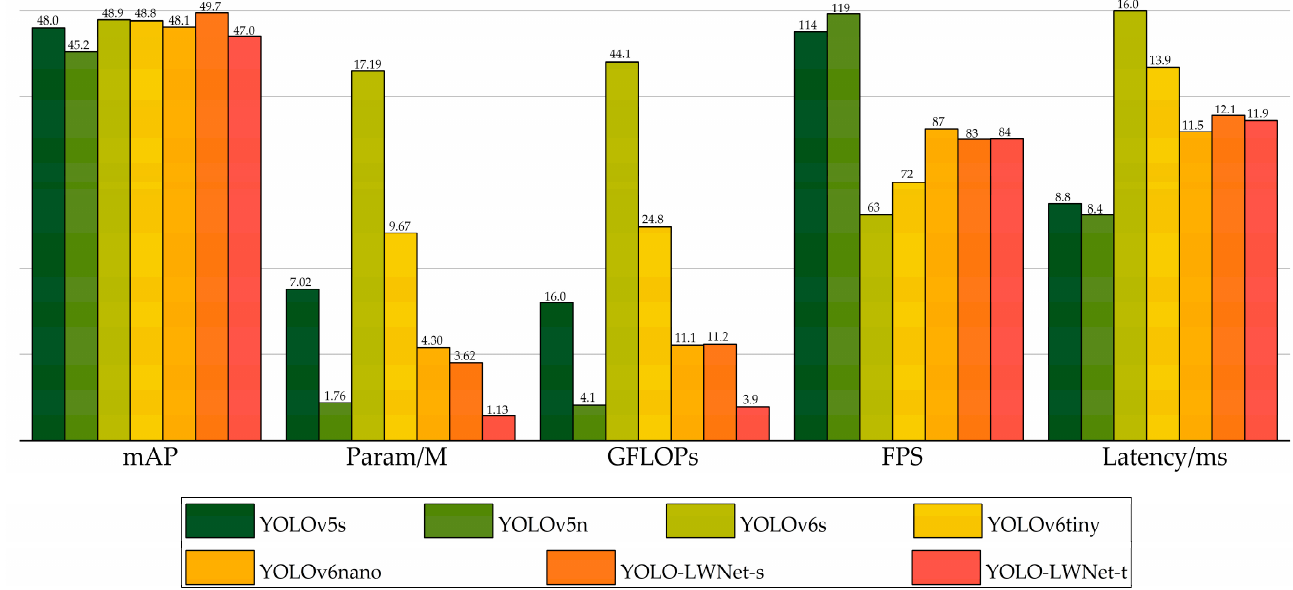
Figure 12. Comparison of different algorithms for object detection on the test set.